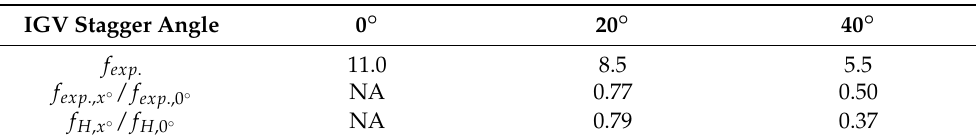
Table 2. Experimental MS frequency, experimental MS frequency ratio, and theoretical MS frequency ratio at each IGV stagger